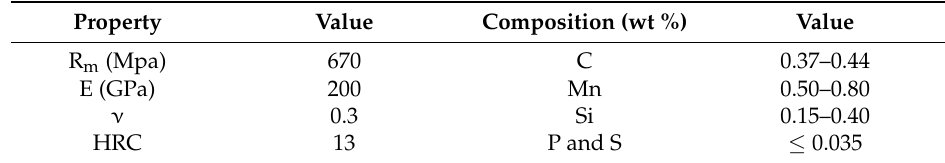
Table 1. Mechanical properties and chemical composition of AISI 1040.